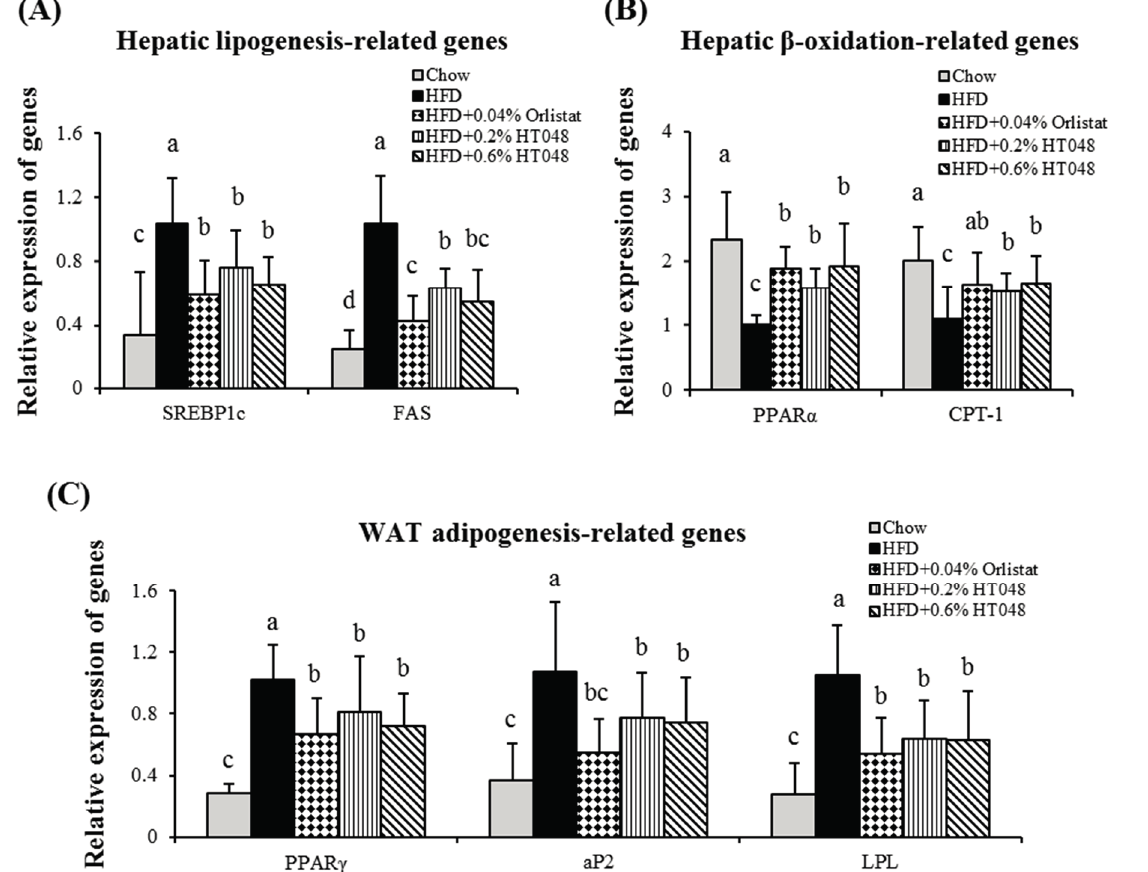
Figure 4. Effect of HT048 on mRNA expression of genes related to hepatic lipogenesis ( A ) and β -oxidation ( B ) and WAT adipogenesis ( C ) in HFD-induced obese rats. Values are presented as the mean ± S.D. ( n = 12). abc Means not sharing common letters are significantly different among the groups at p <